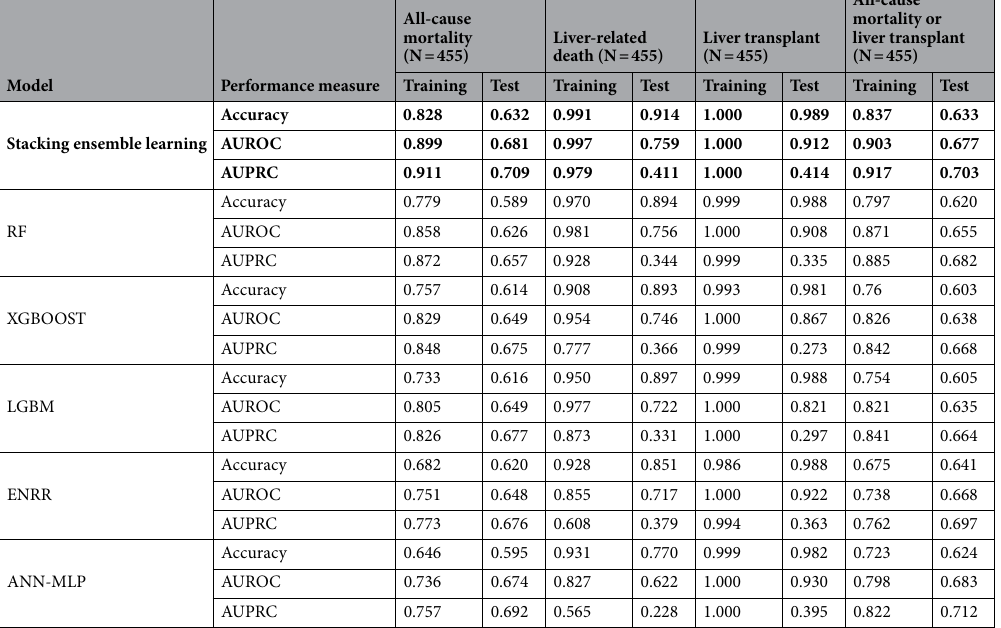
Table 6. Overall predictive model performance measures of stacking ensemble and each base model used in the ML training in patients with AATD-LD. Mean model performance measures were reported in the Training Set and the Test Set, respectively. AATD-LD = alpha-1 antitrypsin deficiency-associated liver disease, AUPRC = area under the precision-recall curve, AUROC = area under the receiver operating characteristic, RF = random forest, XGBOOST = extreme gradient boosting, LGBM = light gradient boosting, ENRR = elastic net regularized regression, ANN-MLP = artificial neural network multilayer perceptron. Model performance measures from the stacking ensemble learning model are in